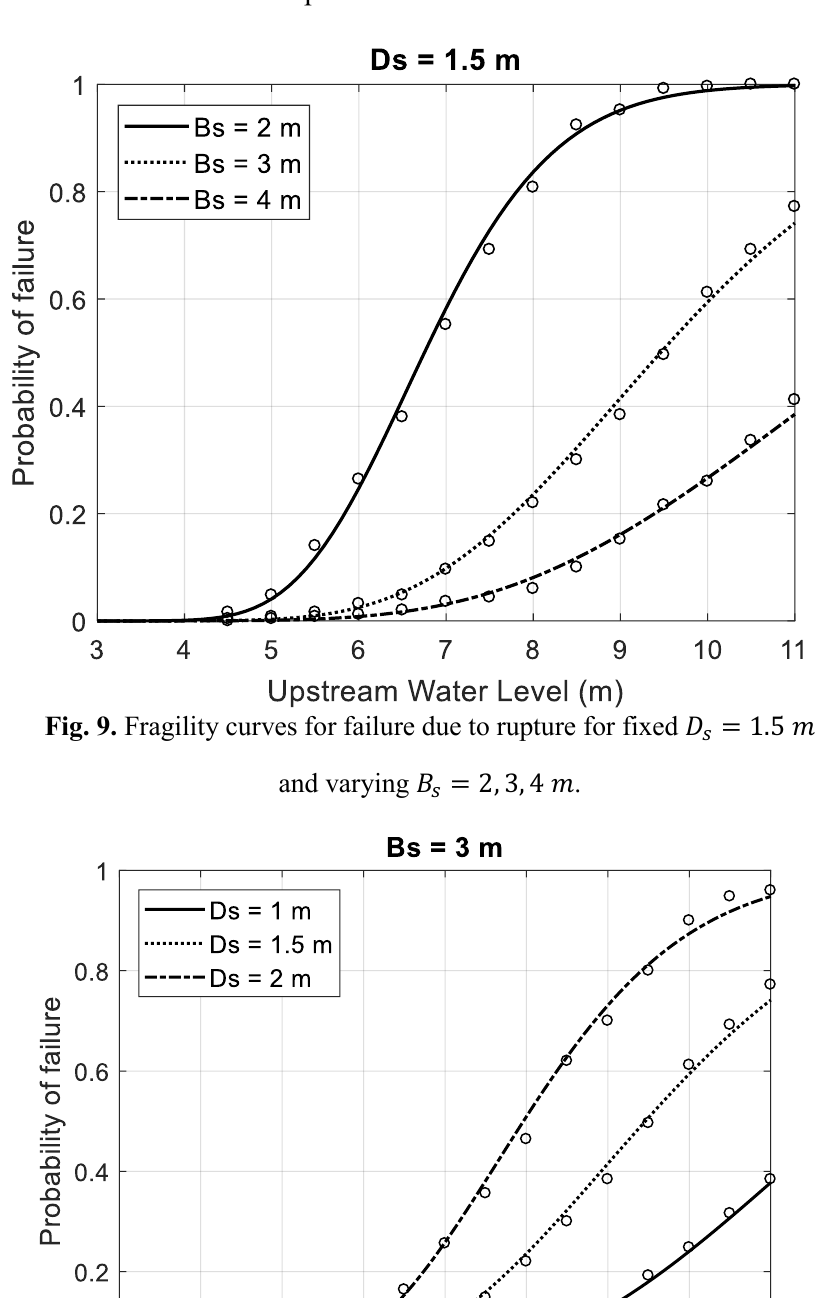
Fig. 10 . Fragility curves for failure due to rupture for fixed 𝐵